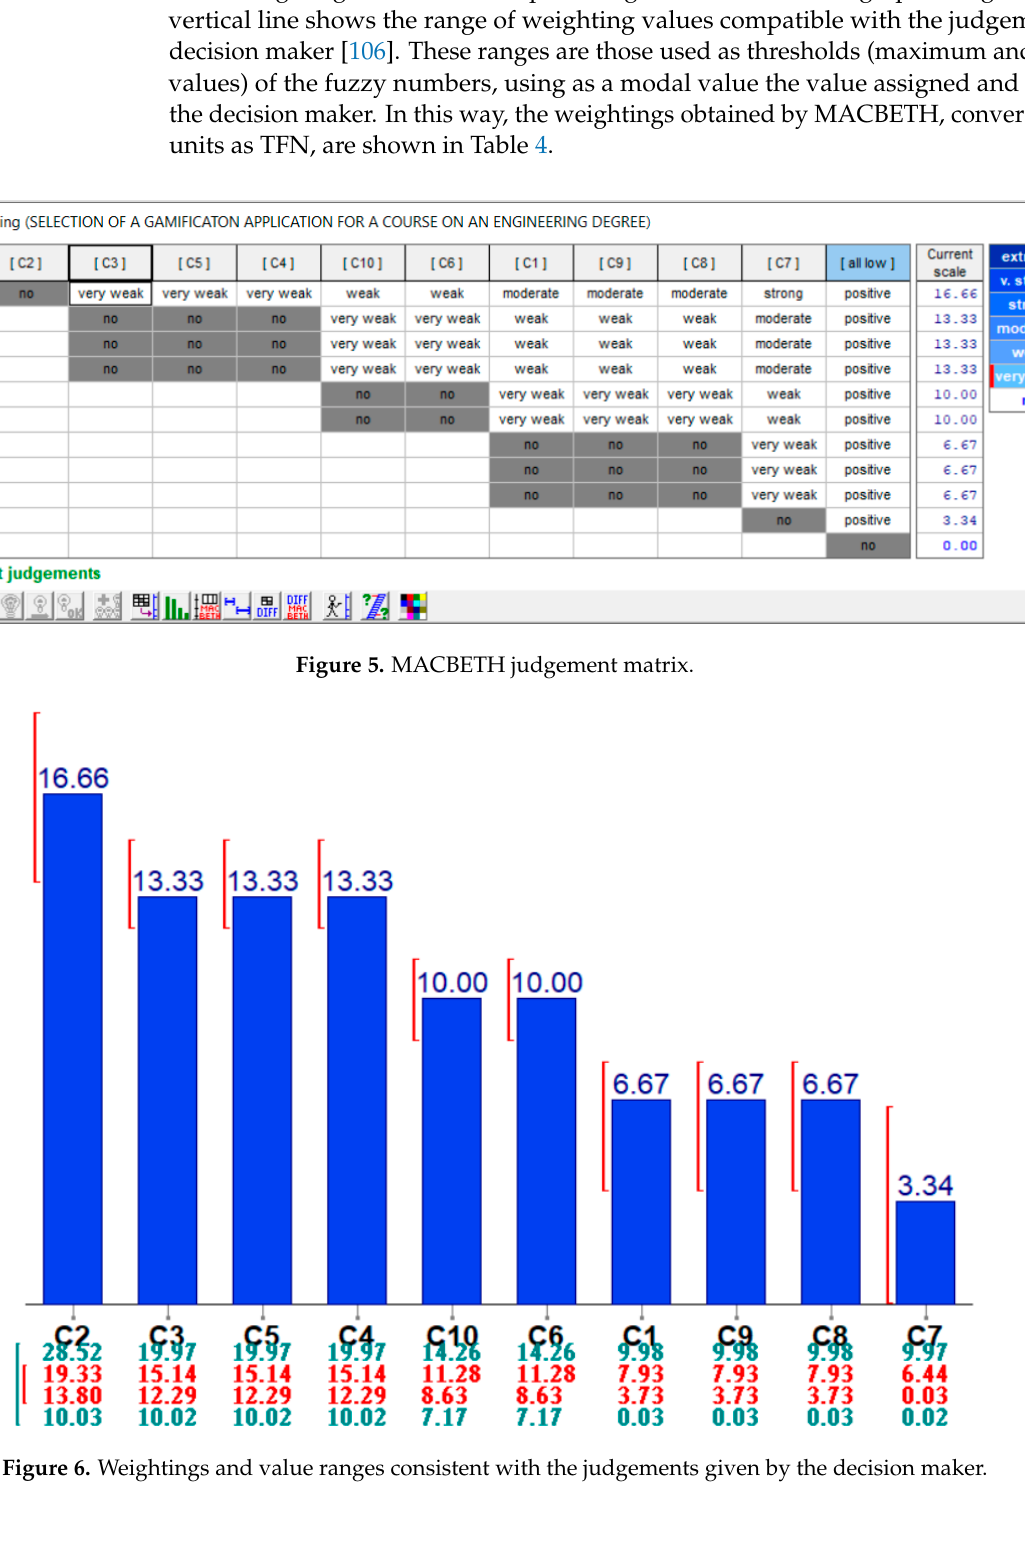
Figure 4. ( a ) MACBETH judgement matrix of the Academic performance criterion; ( b ) value function.